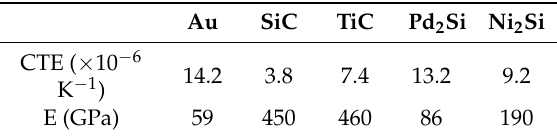
Figure 11. SEM fracture morphologies of the SiC/SiC joints brazed using (Au 79 Ni 17 Pd 4 ) 96 Ti 4 (wt.%) under different joining conditions: ( a ) 1423 K/10 min; ( b ) 1473 K/10 min; ( c ) 1523 K/10 min; ( d ) 1573 K/10 min; ( e ) 1523 K/30 min; ( f ) 1523 K/60 min; ( g ) 1523 K/90 min. Table 2. Coefficients of thermal expansion (CTEs) and Young’s moduli € of related phases in the joint [31–36].